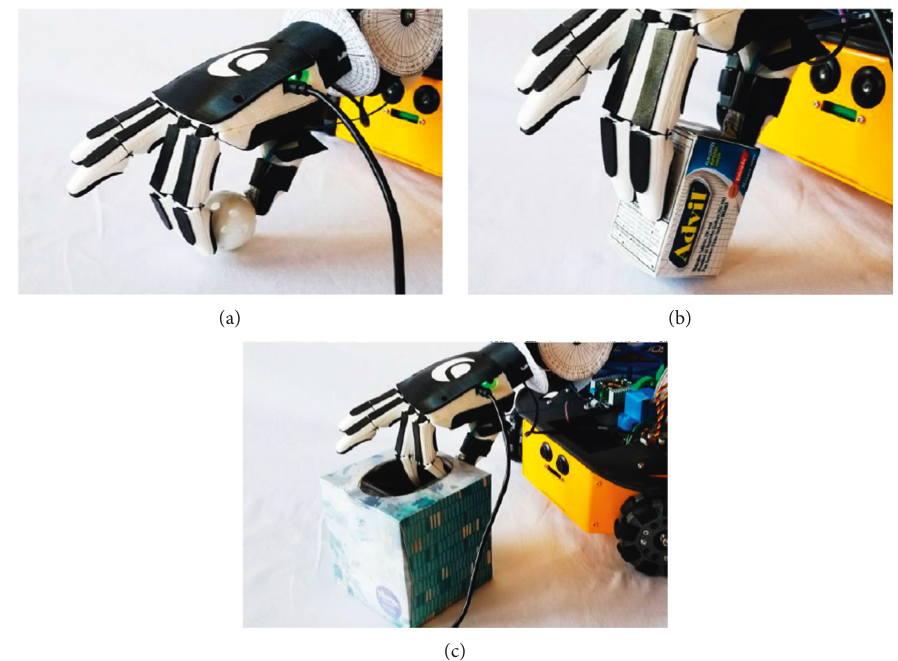
Figure 26: Gripping modes of Brunel Hand based on the object